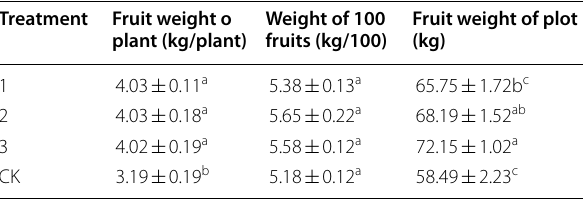
Table 3 Fruit weight of plant, weight of 100 fruits and fruit weight of plot in the